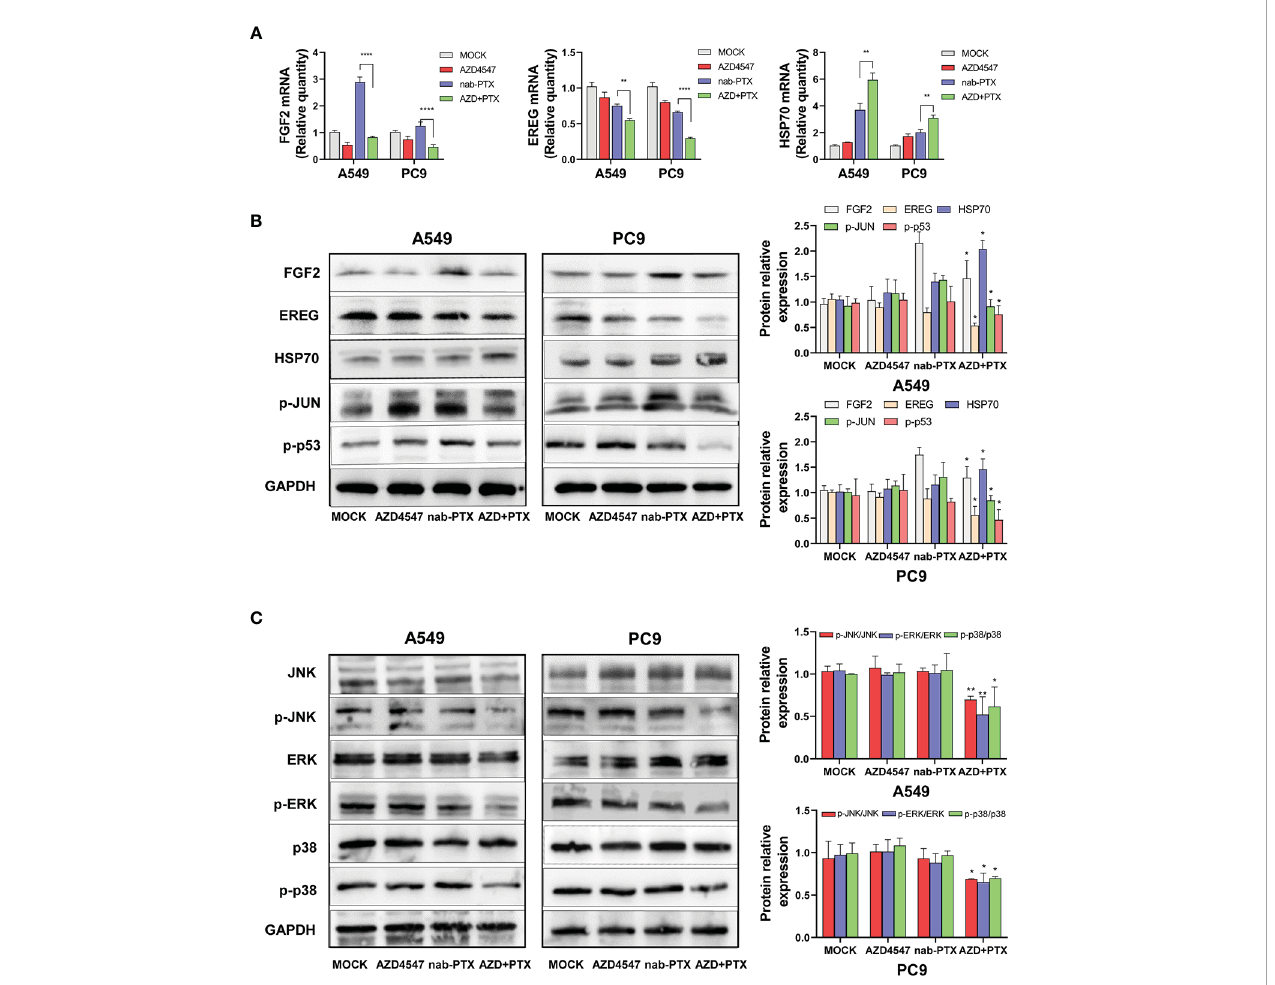
FIGURE 6 Effects of AZD4547 and nab-PTX on the MAPK signaling pathway. (A) The expression of FGF2, EREG, and HSP70 was assessed by qRT − PCR. (B) Western blot analysis of the protein expression of FGF2, EREG, and HSP70 and the phosphorylation of JUN and p53. (C) AZD4547 combined with nab-PTX inhibited phosphorylation of the JNK, ERK, and p38 proteins. *: p< 0.05, **: p< 0.01, ****: p<